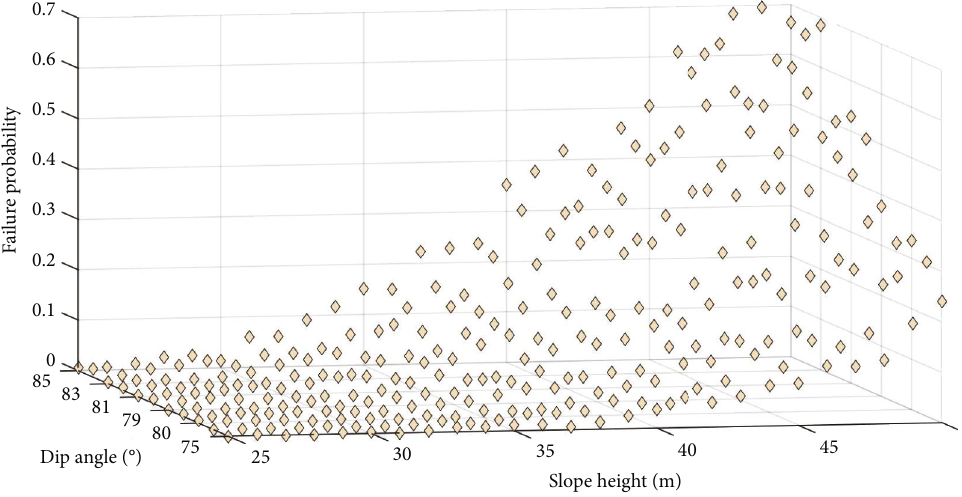
Figure 17: Statistical diagram of failure probability under di ff erent combinations of slope height and slope